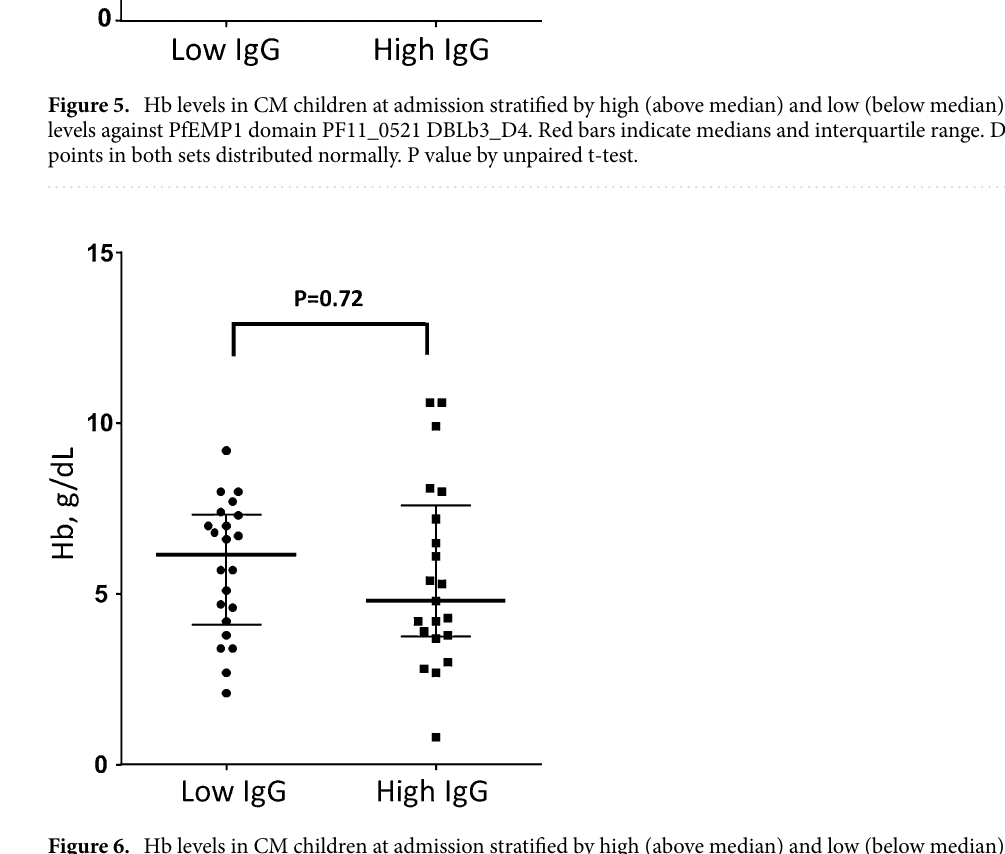
Figure 6. Hb levels in CM children at admission stratified by high (above median) and low (below median) IgG levels against AMA-1. Red bars indicate medians and interquartile range. Data points in both sets distributed normally. P value by unpaired